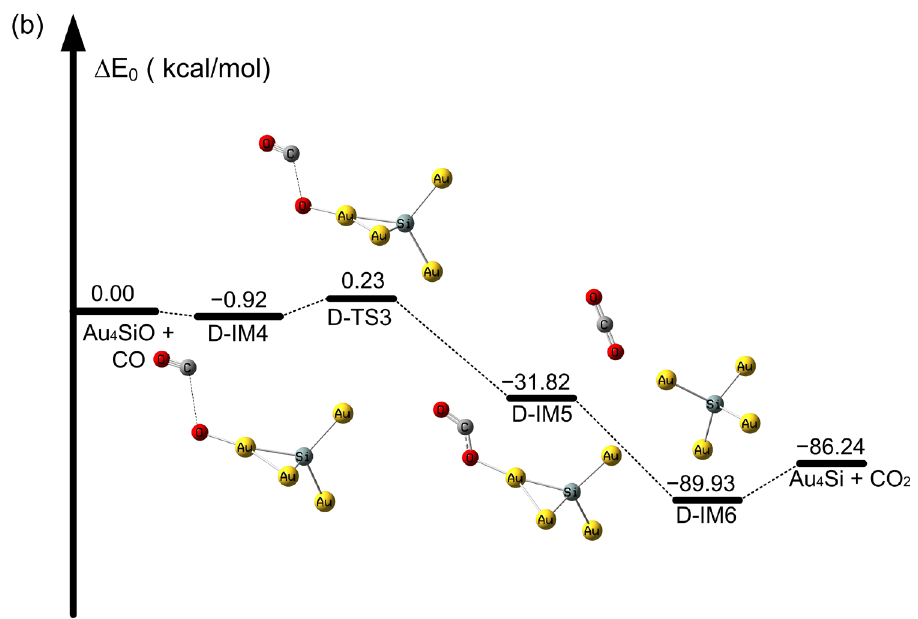
Figure 5. Potential energy profile of CO oxidation on SiAu 4 atoms at the CAM-B3LYP/aug-cc-pVDZ- PP level. ( a ) Oxidation of CO on the Au 4 Si cluster and ( b ) oxidation of CO on the OSiAu 4 cluster (in kcal/mol).